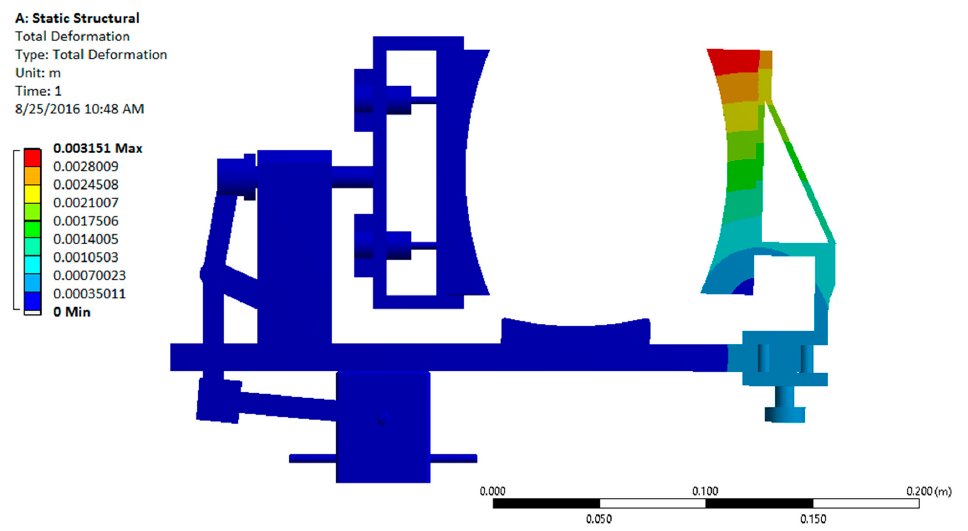
Figure 11. Total deformation plot of the device under the static loading conditions.